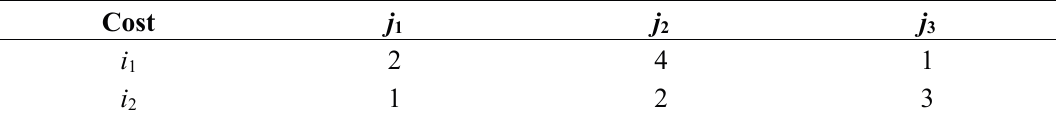
Table 2. Cost matrix A = [ c ij ] 2 × 3